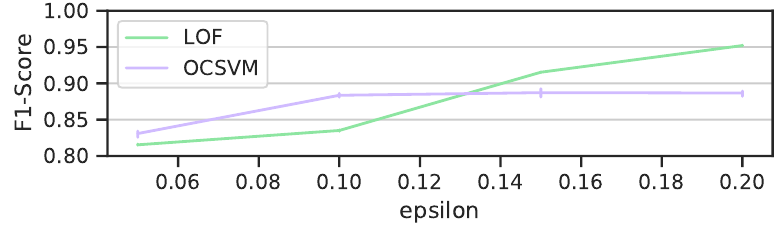
Figure 9. F1-Score variation from (cid:101) using LOF and OCSVM.